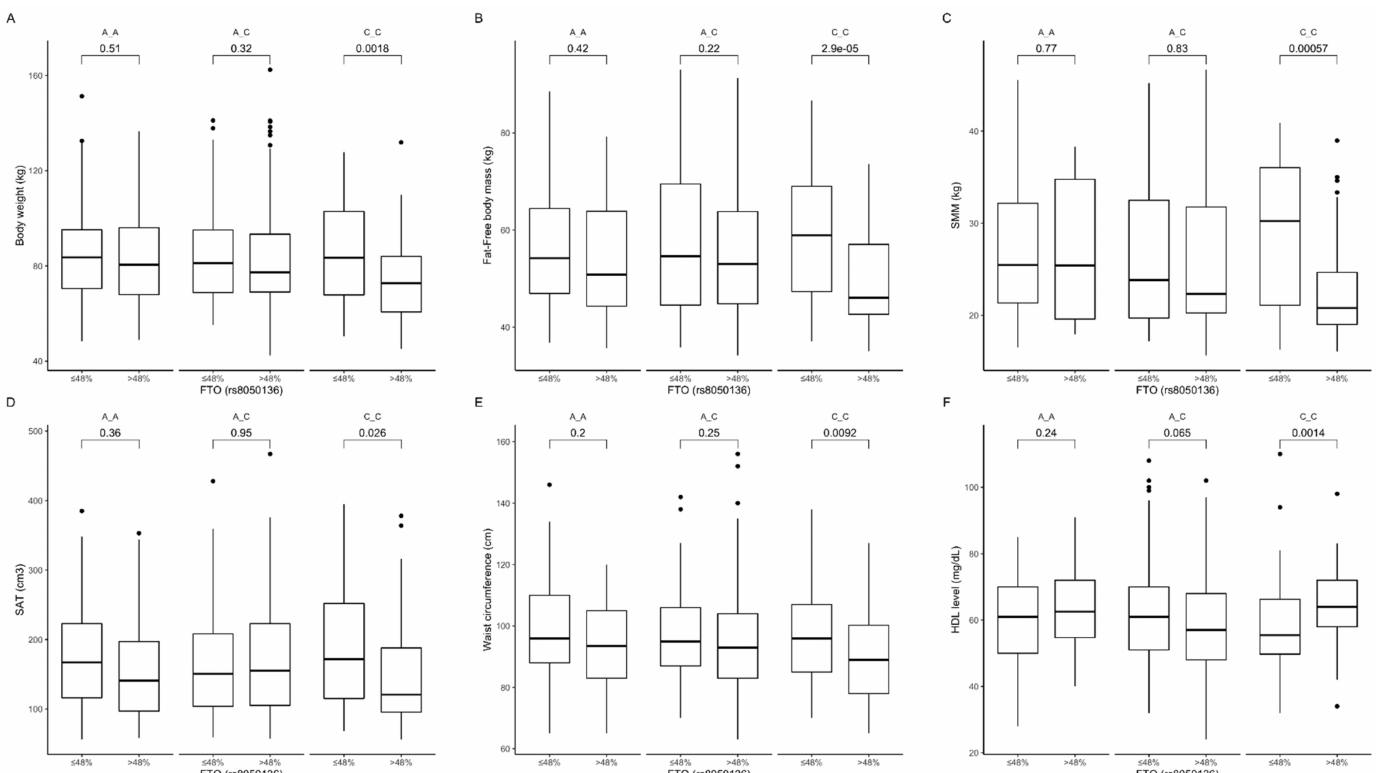
Figure 6. Association of FTO genotypes rs8050136 with ( A ) body weight (kg), ( B ) fat-free body mass (kg), ( C ) skeletal muscle mass (SMM) (kg), ( D ) SAT (cm 3 ), ( E ) waist circumference (cm 3 ), and ( F ) HDL level (mg / dL) by dietary carbohydrate intake strata: ≤ 48% and > 48% of total daily energy